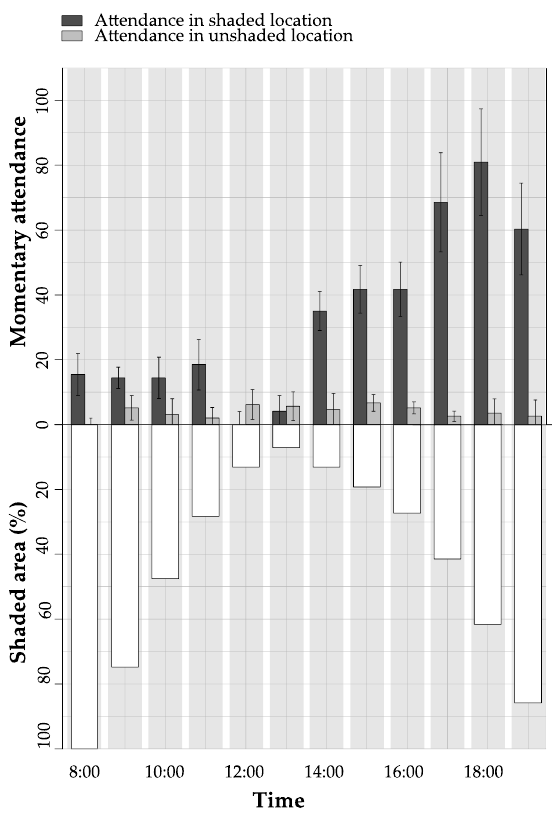
Figure 3. Hourly median and standard deviation of the attendance for shaded (dark grey) and unshaded (light grey) locations, on 1st and 2nd of August 2014, from 8:00 to 19:00, compared with the hourly percentage of shaded area (white bars) in San Silvestro Square [3].